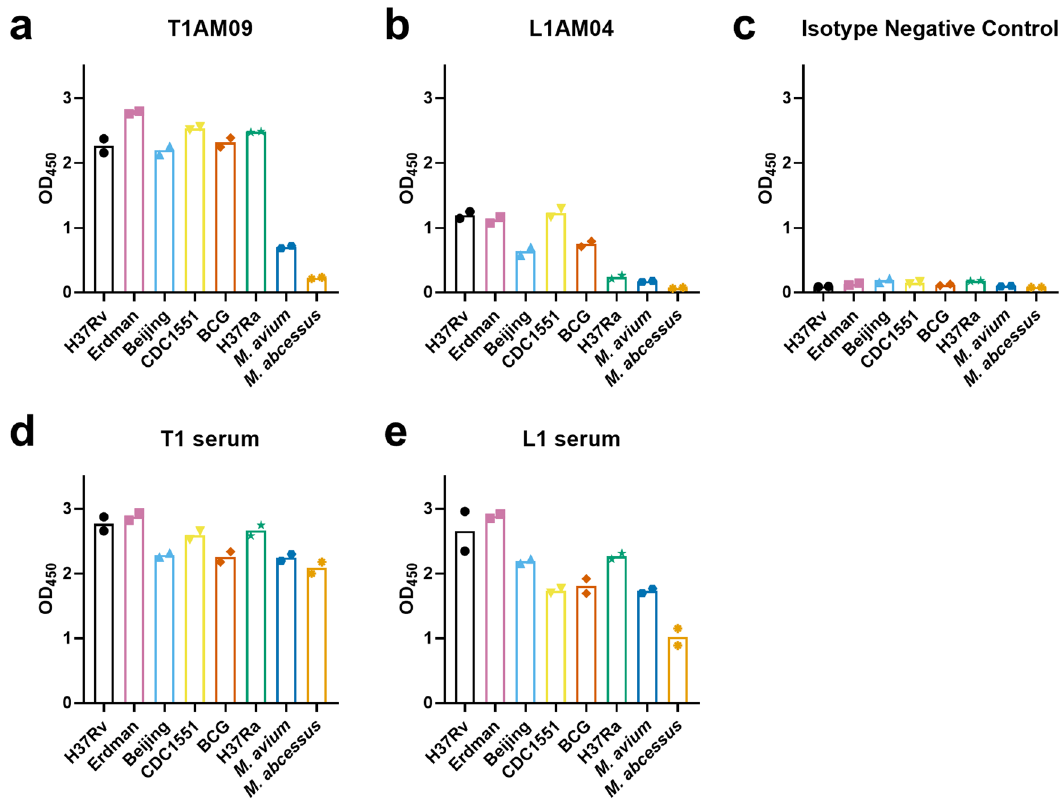
Fig. 7 T1AM09 and L1AM04 show distinct binding to mycobacterial strains by whole-cell ELISA (mycobacteria were grown without detergent to preserve the capsule). Binding of human IgG1 mAbs (50 µ g/mL) and polyclonal serum IgG (1:20 dilution) to virulent laboratory (H37Rv and Erdman) and clinical strains (CDC1551 and Beijing) of Mtb , avirulent strains of the Mtb complex group (H37Ra and BCG Pasteur) and nontuberculous mycobacteria ( M. avium and M. abscessus ) assessed at optical density (OD) of 450 nm for a T1AM09; b L1AM04; c Isotype-matched negative control IgG1 mAb to a fl avivirus; and positive controls, d Subject T1 serum; and e Subject L1 serum. The data shown are representative from two separate